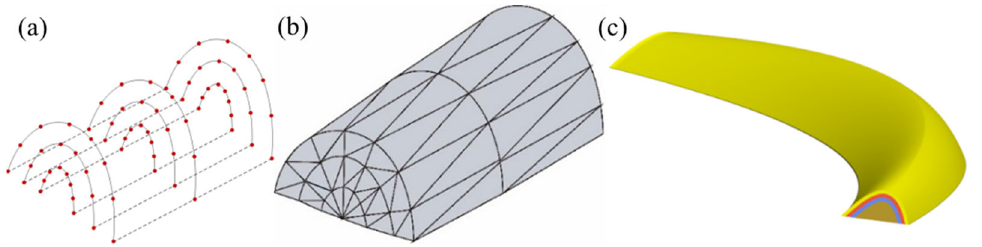
Figure 12. Fold surface model constructed based on the contour algorithm, ( a ) adjacent sections after morphing, ( b ) surface model constructed using the contour algorithm, and ( c ) fold symbol model result. Entities with different colors represent different strata.